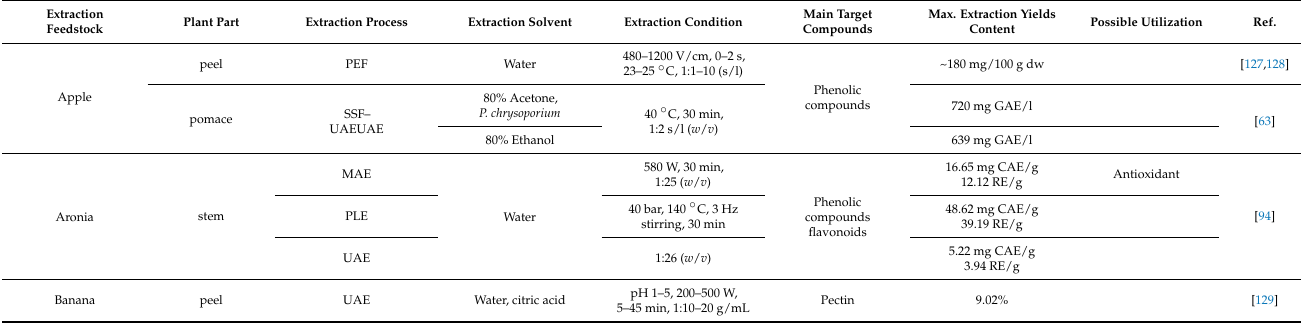
Table A2. Extraction process